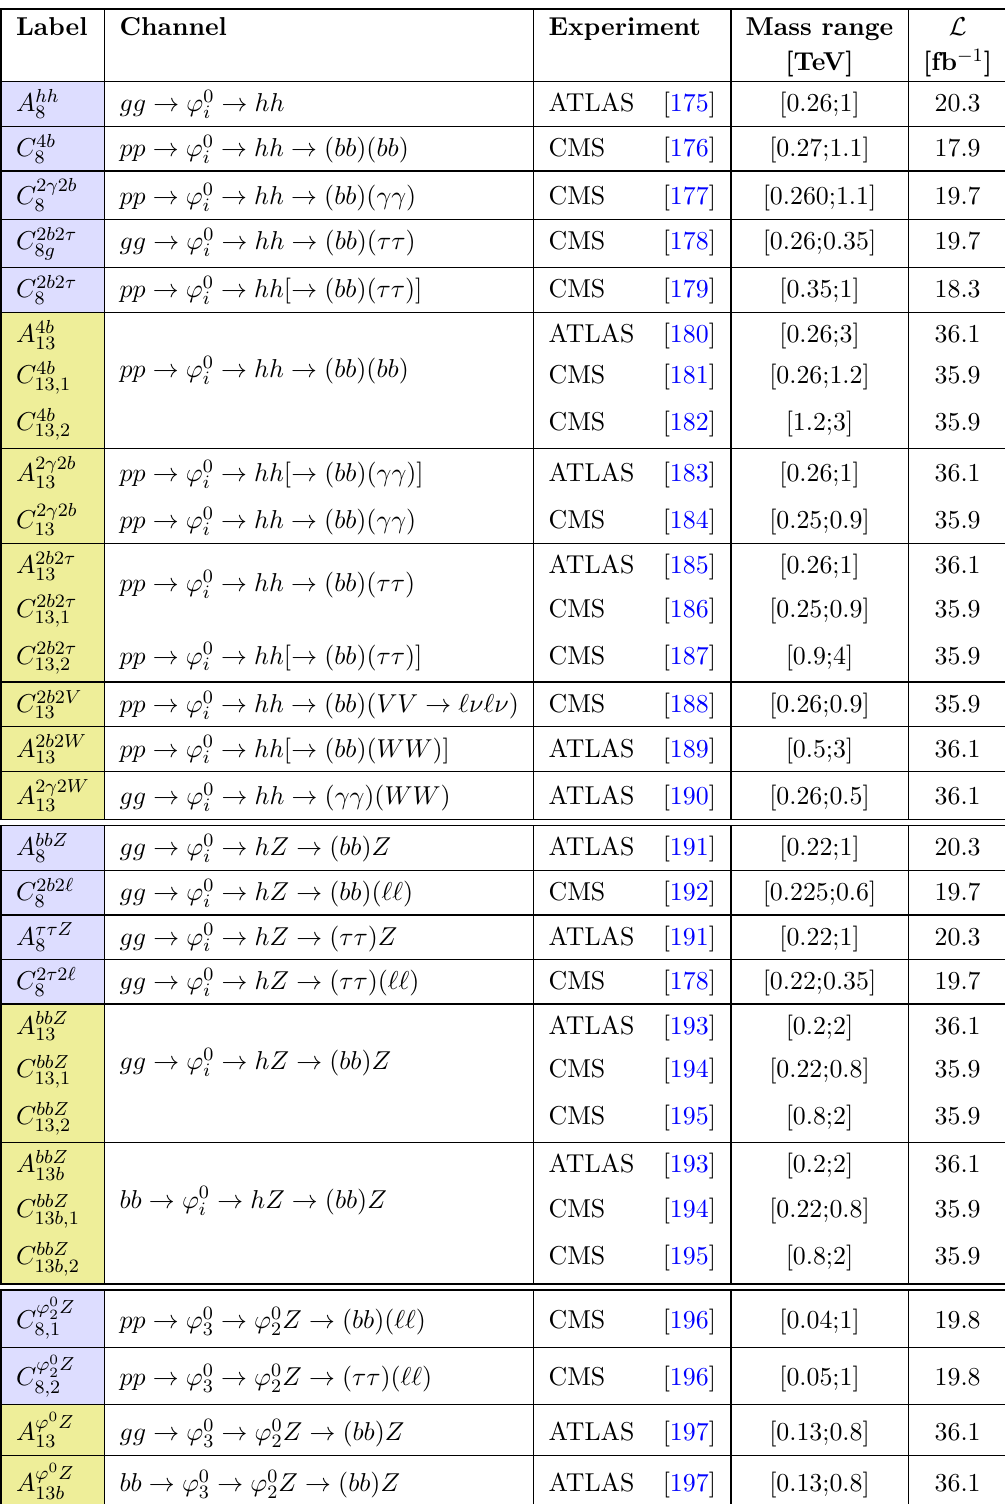
Table 8. Direct searches for neutral heavy scalars, ϕ 0 Higgs boson or other neutral scalars. ϕ 3 denotes the heaviest scalar, V = W, Z , ‘ = e, µ